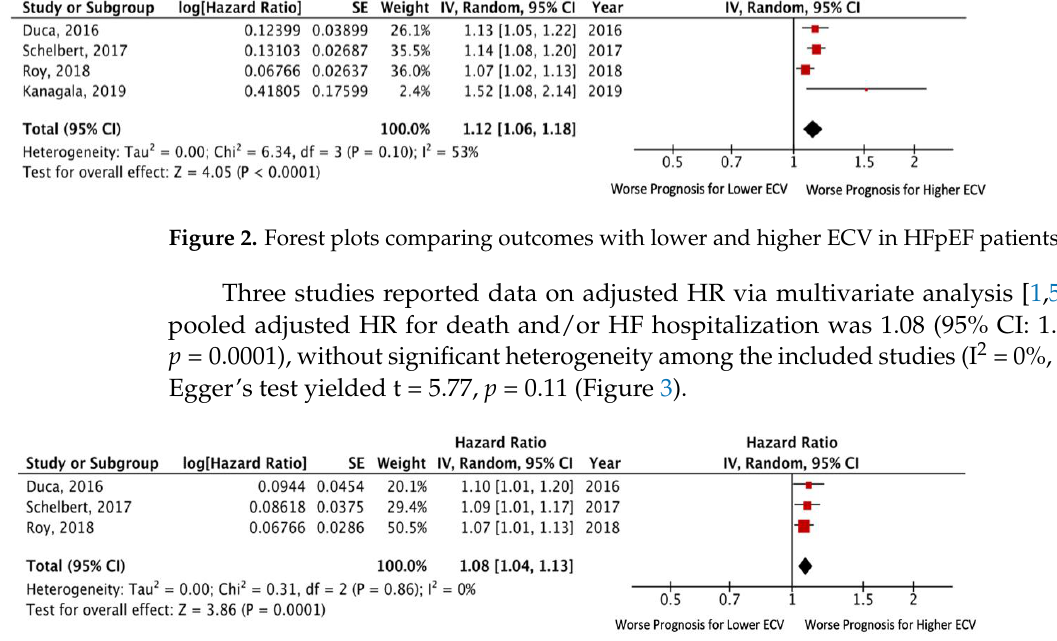
Figure 3. Forest plots comparing outcomes with lower and higher ECV in HFpEF patients.